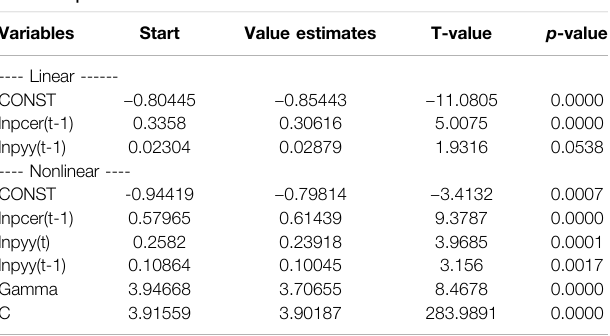
TABLE 3 | Parameter estimation